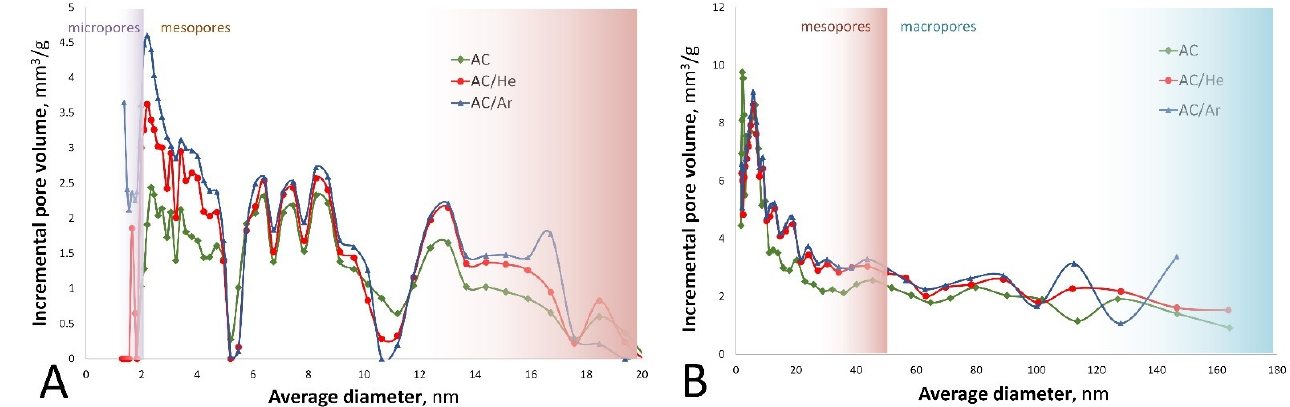
Figure 5. Pore size distribution of AC: ( A ) according to DFT model, ( B ) according to BJH model. For observation purposes, microscopic images of both materials after helium and ar- gon activation were taken. The photos are presented in Figure 6. The materials studied after activation looked similar microscopically. They had different textures and particles in the form of agglomerates (Figure 6C,F). Figure 6. Images of samples: ( A ) AC/He, ( B ) AC/Ar, ( C ) AC/Ar, ( D ) BSG-HC/He, ( E ) BSG-HC/Ar, ( F ) BSG-HC/Ar. Based on the study of two different materials (BSG-HC and AC), it was observed that the choice of plasma gas is important in terms of increasing the pore structure of the ma- terials and potentially increasing the sorption capacity. In the presented study, a different plasma jet power was used to generate plasmas using argon and helium. This was deter- mined by the need to maintain plasma jet stability in each of the two cases. It was not possible to maintain stable jet operation at the same power for two different gases due to their respective properties. In addition, a higher sorption capacity was obtained for the Ar plasma, which used a relatively lower power of 13 W compared with 17 W for the He plasma. To assess the effect of the activations used on the BSG-HC and AC, the ratio of the quantity adsorbed of the activated samples relative to the samples without activation was